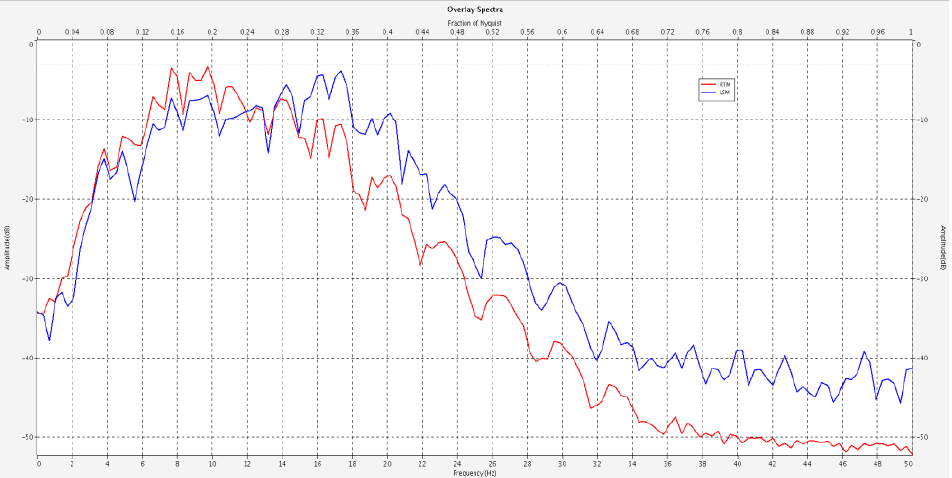
Figure 7. The comparison of vertical-wave-number spectrum between RTM (red) and LSM (blue) from Figures 3 and 5. The unit of y-axis is decibel, and x-axis indicates the wavenumber component.